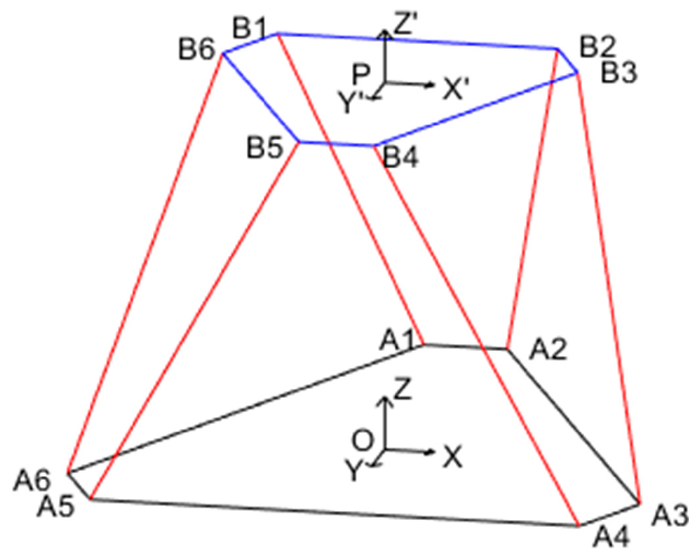
Figure 1. Space geometric model of parallel platform.